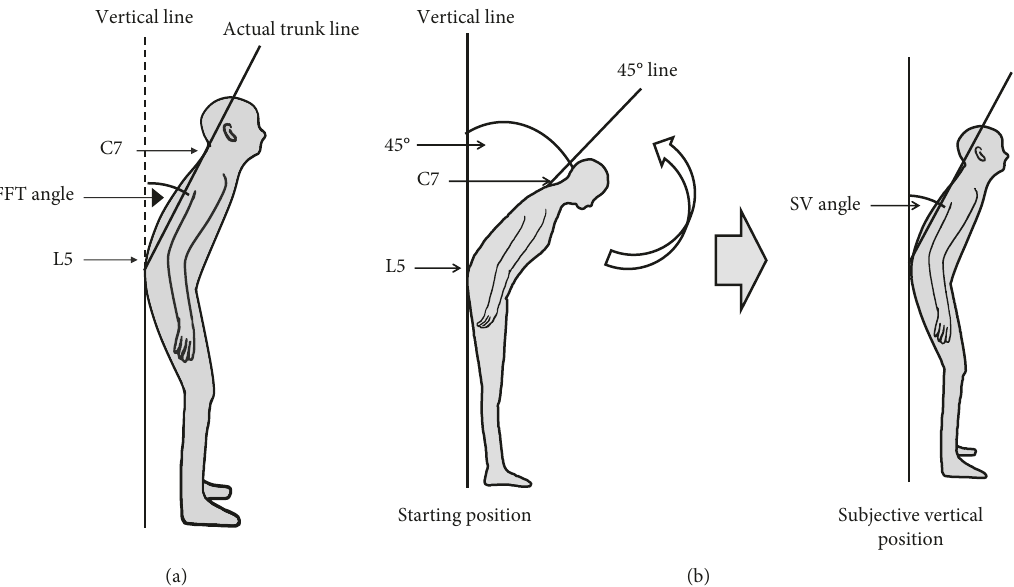
Figure 1: Diagrams illustrating measurement of (a) forward flexion of the trunk (FTT) and (b) subjective vertical position (SV).